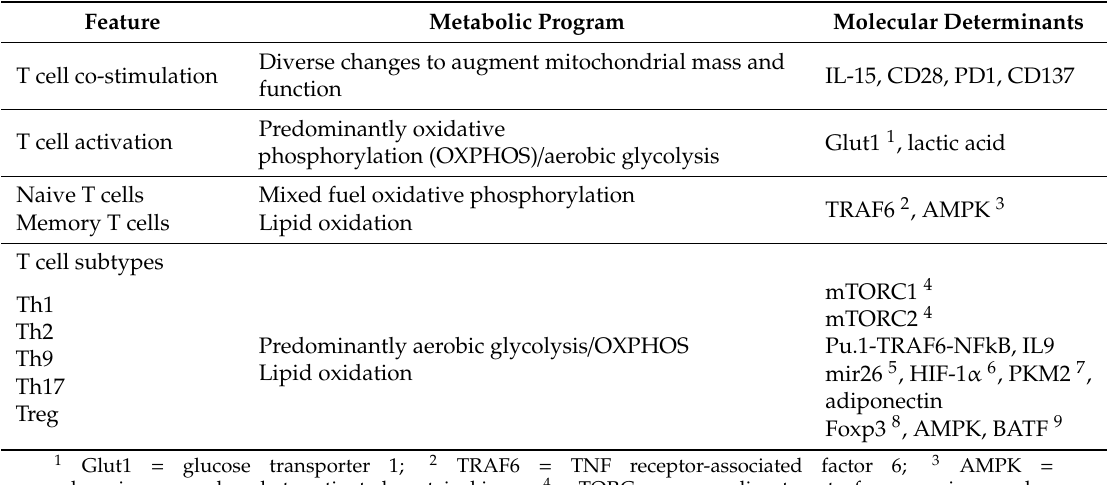
Table 3. Metabolic regulation of T